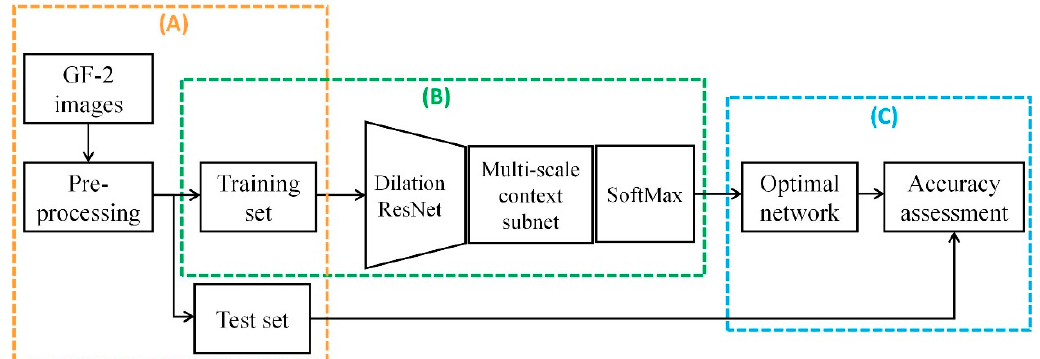
Figure 2. Flowchart of the proposed research framework: ( A ) generate data sets, ( B ) model training, and ( C ) accuracy assessment.